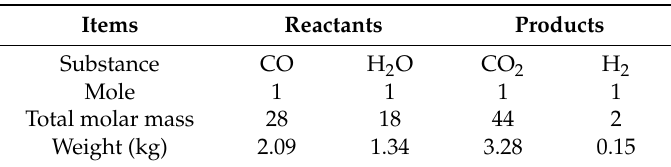
Table 4. Water-gas shift reaction.